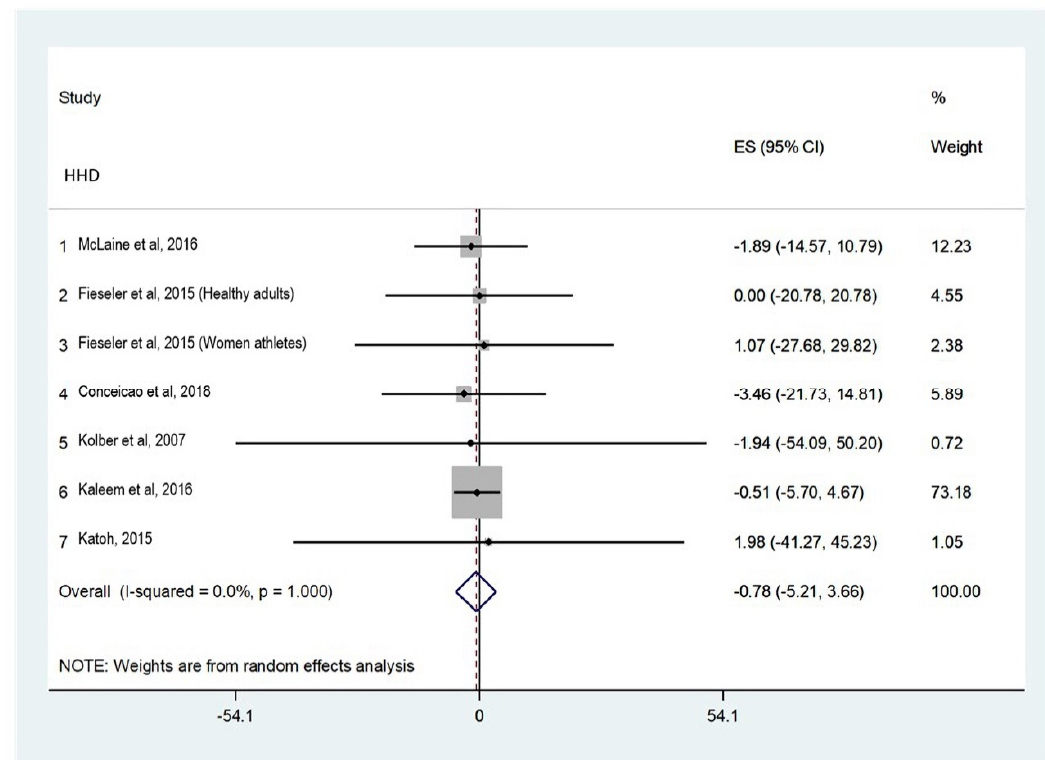
Figure 2. Absolute reliability for shoulder internal rotator strength assessment.